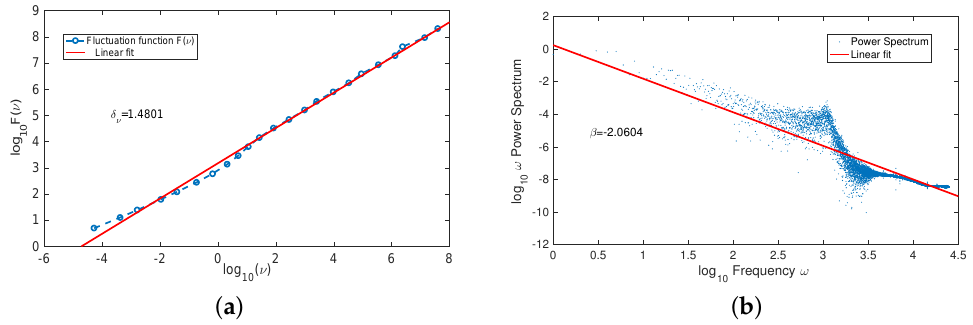
Figure 3. ( a ) DFA for the time series obtained from the electronic circuit. ( b ) Power law analysis of the frequency